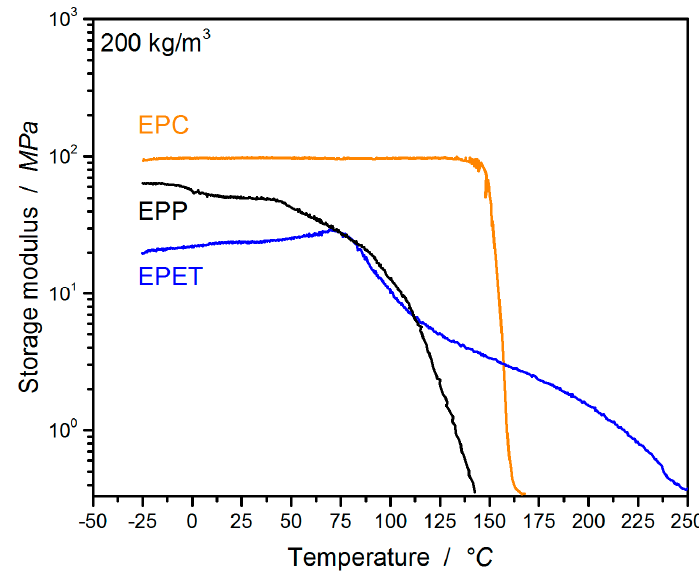
Figure 3. Dynamic-mechanical analysis (DMA) temperature sweep (1 K/min) for EPP, EPC, and EPET bead foam parts at 200 kg/m 3 .